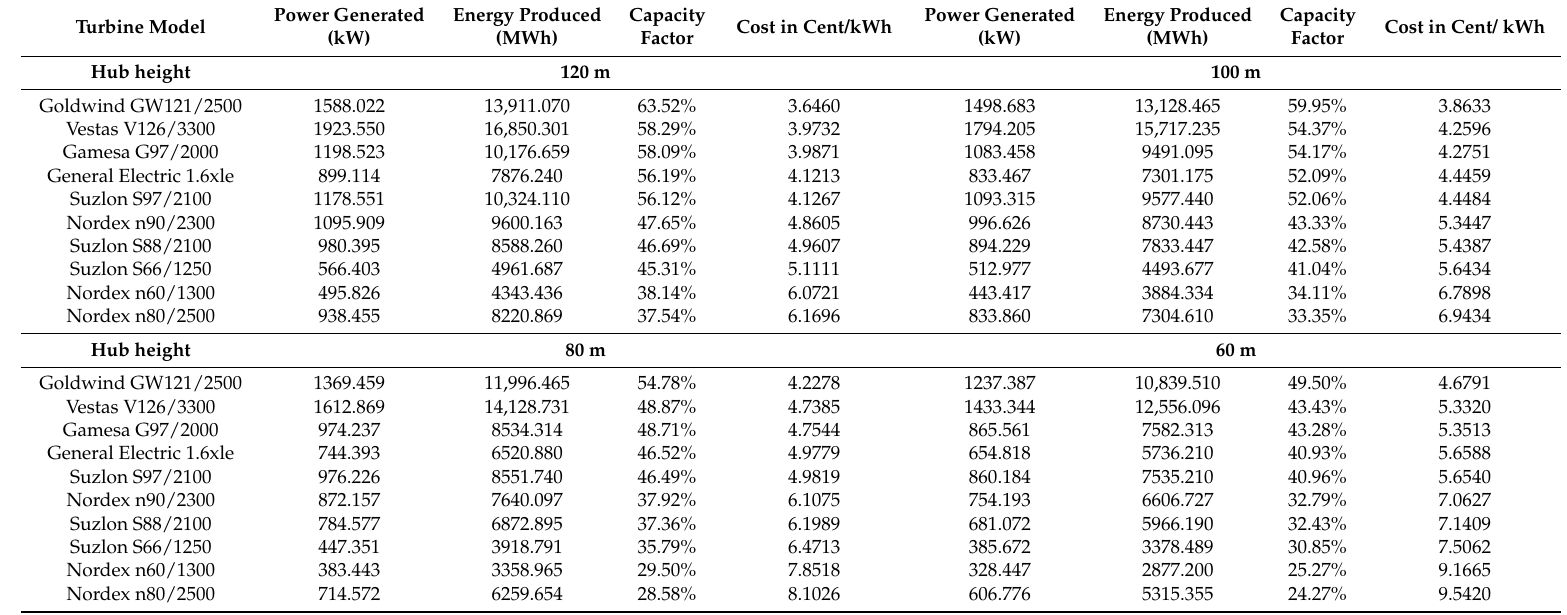
Table 5. Power generated, the energy produced and capacity factor of ten different turbine